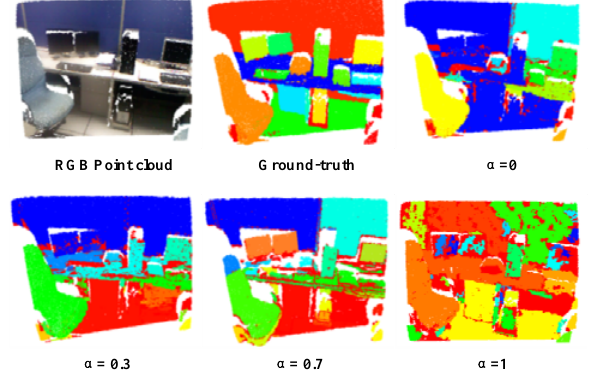
Figure 4. Comparison of the segmentation results with different weight